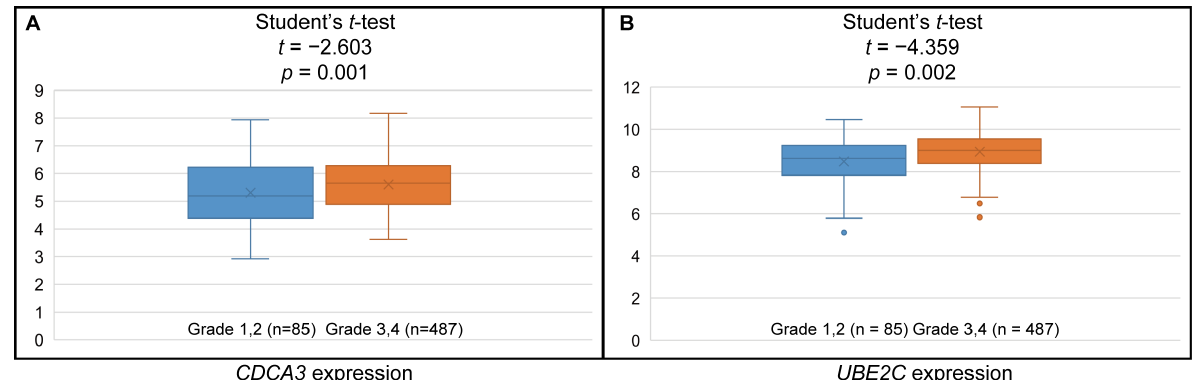
Figure 9. Higher expression levels of CDCA3 and UBE2C are associated with higher histologic grade of tumor. ( A ) Box plot of the relative CDCA3 expression levels and ( B ) UBE2C expression levels in the grade 1 and 2 and grade 3 and 4 serous ovarian cancer tissues.